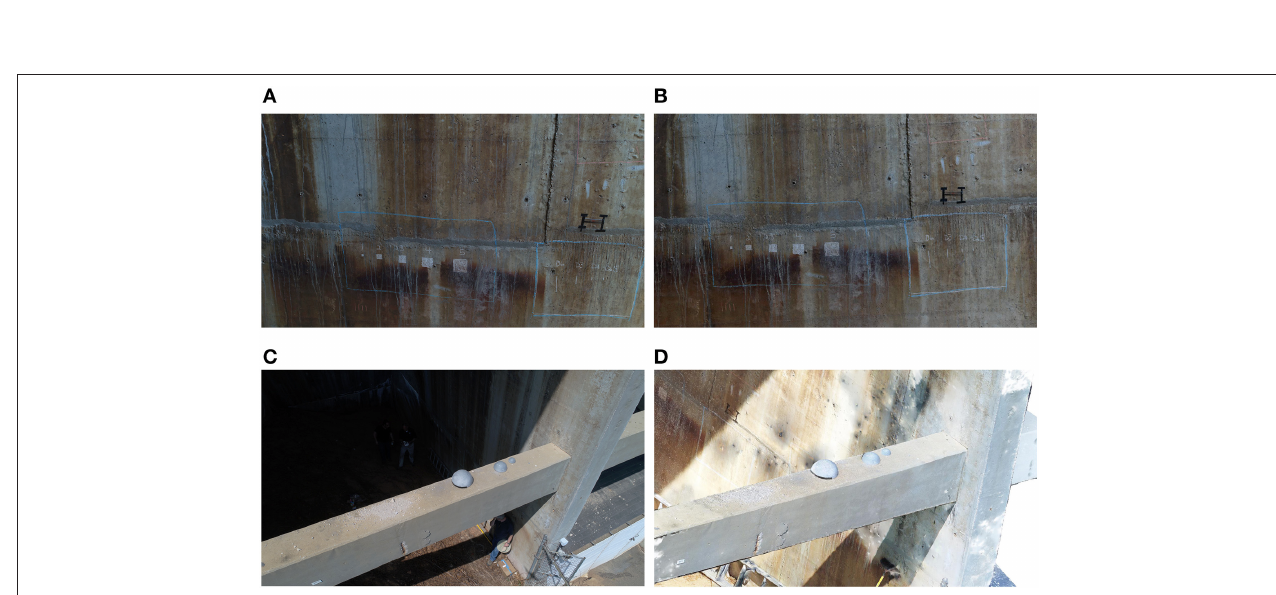
FIGURE 5 | Controlled simulated damages: (A) 2D image of Type 1 and 2 defects; (B) 3D point cloud rendering of Type 1 and 2 defects; (C) 2D image of Type 3 volumetric defects; (D) 3D point cloud rendering of Type 3 volumetric defects.